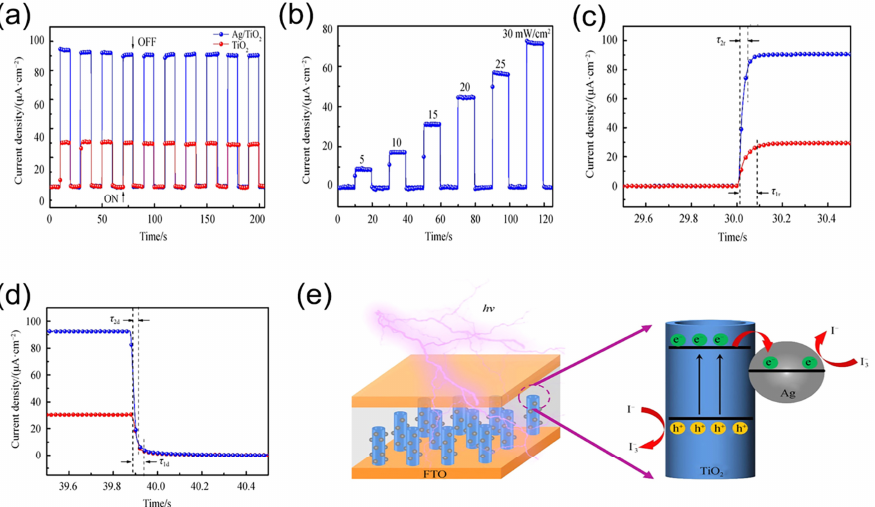
Figure 3. The patterns of time − dependent current response ( a ) measured under on/off UV illumina- tion, current density ( b ) as a function of the incident UV light intensity, rising edges ( c ) and decaying edges ( d ), and ( e ) schematic diagram of the charge transfer of the UV detector based on Ag/TiO 2 nanotubes. Reproduced with permission from Ref. [2]; published by Science Press, 2019.